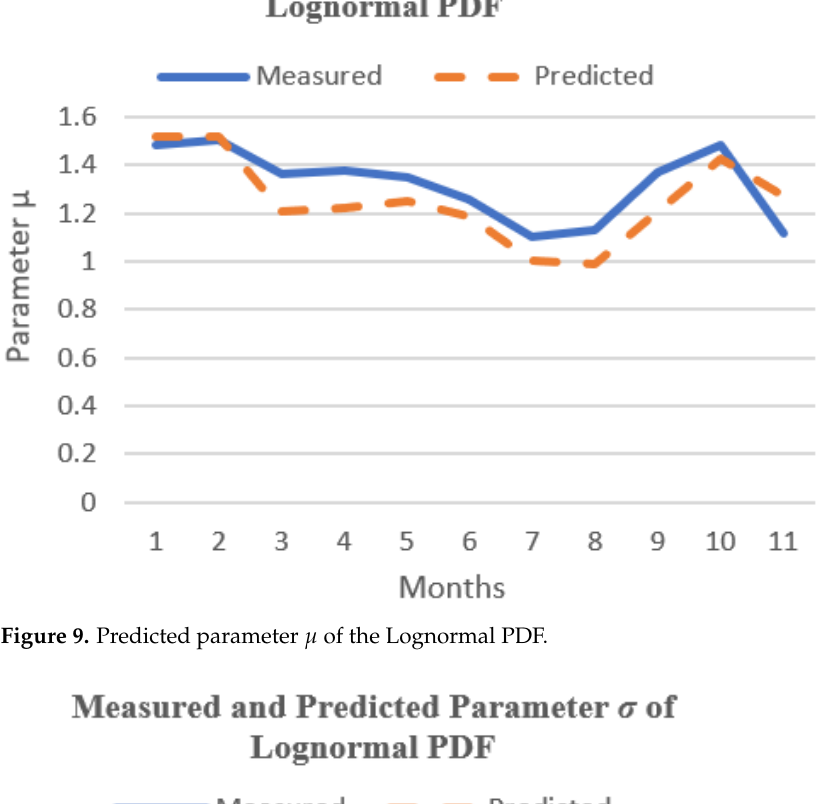
Figure 9. Predicted parameter µ of the Lognormal PDF.